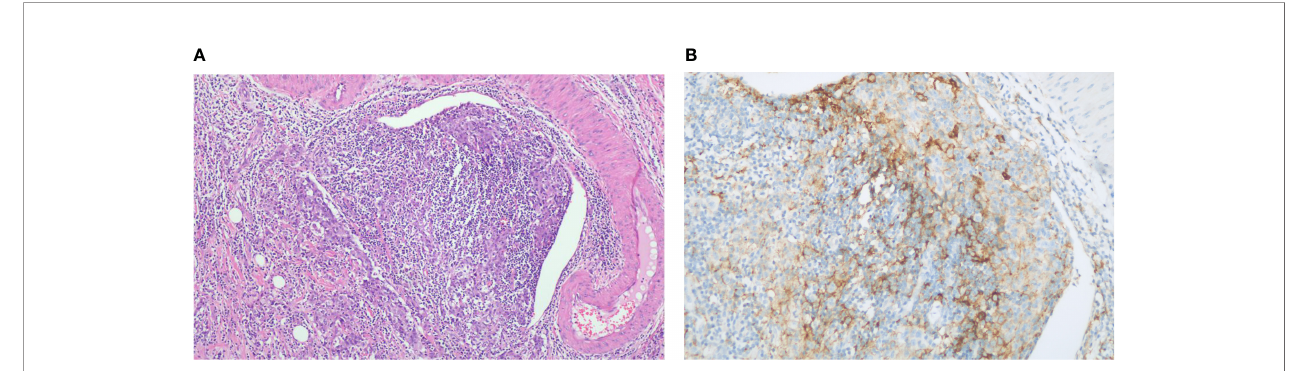
FIGURE 2 | Histopathology of gallbladder carcinoma. (A) H&E stain, original magni fi cation ×100. (B) PD-L1 immunohistochemistry (antibody Ventana SP263), original magni fi cation ×200.